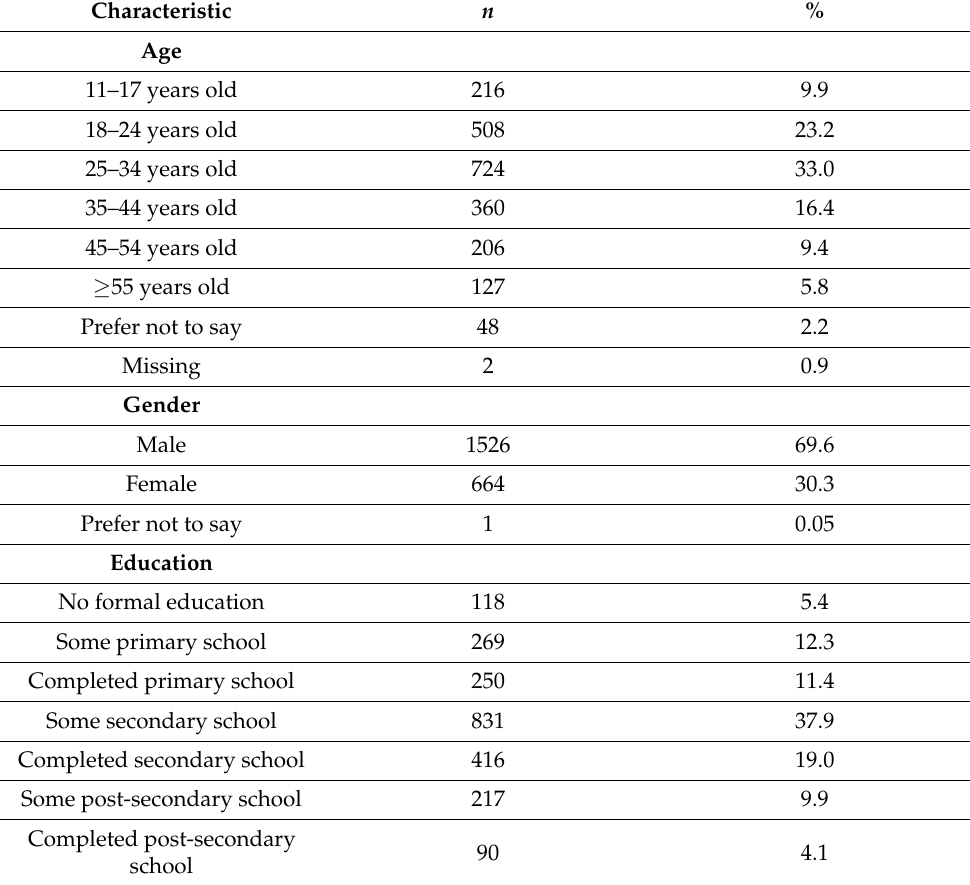
Table 2. Demographic characteristics for total number of participants.